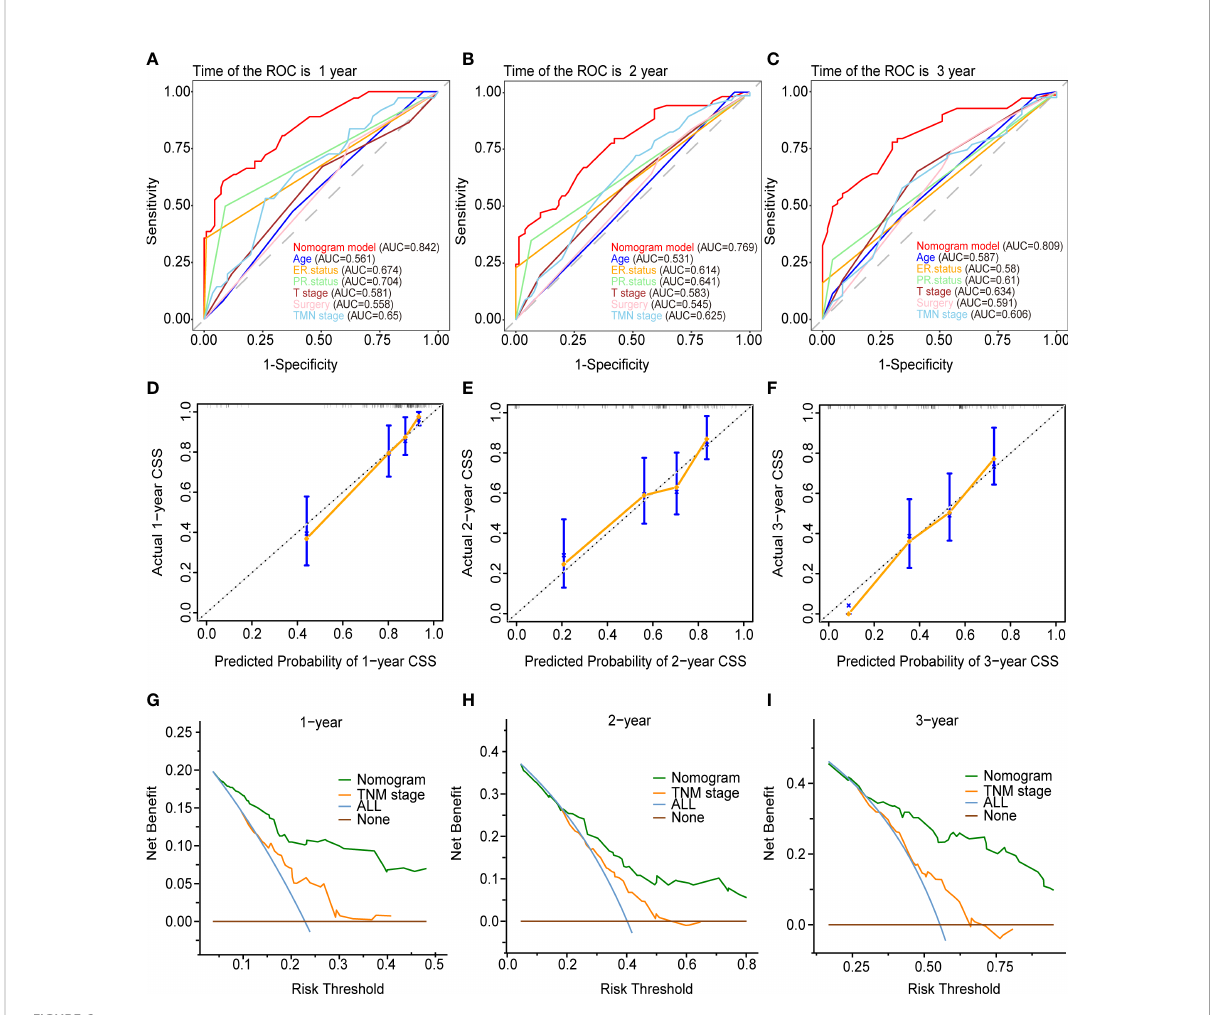
FIGURE 6 Validation of the prognostic nomogram for the 12-,24- and 36months CSS. (A – C) The receiver operating characteristic curves (ROC). (D – F) The calibration curves. (G – I) The decision curve analyses